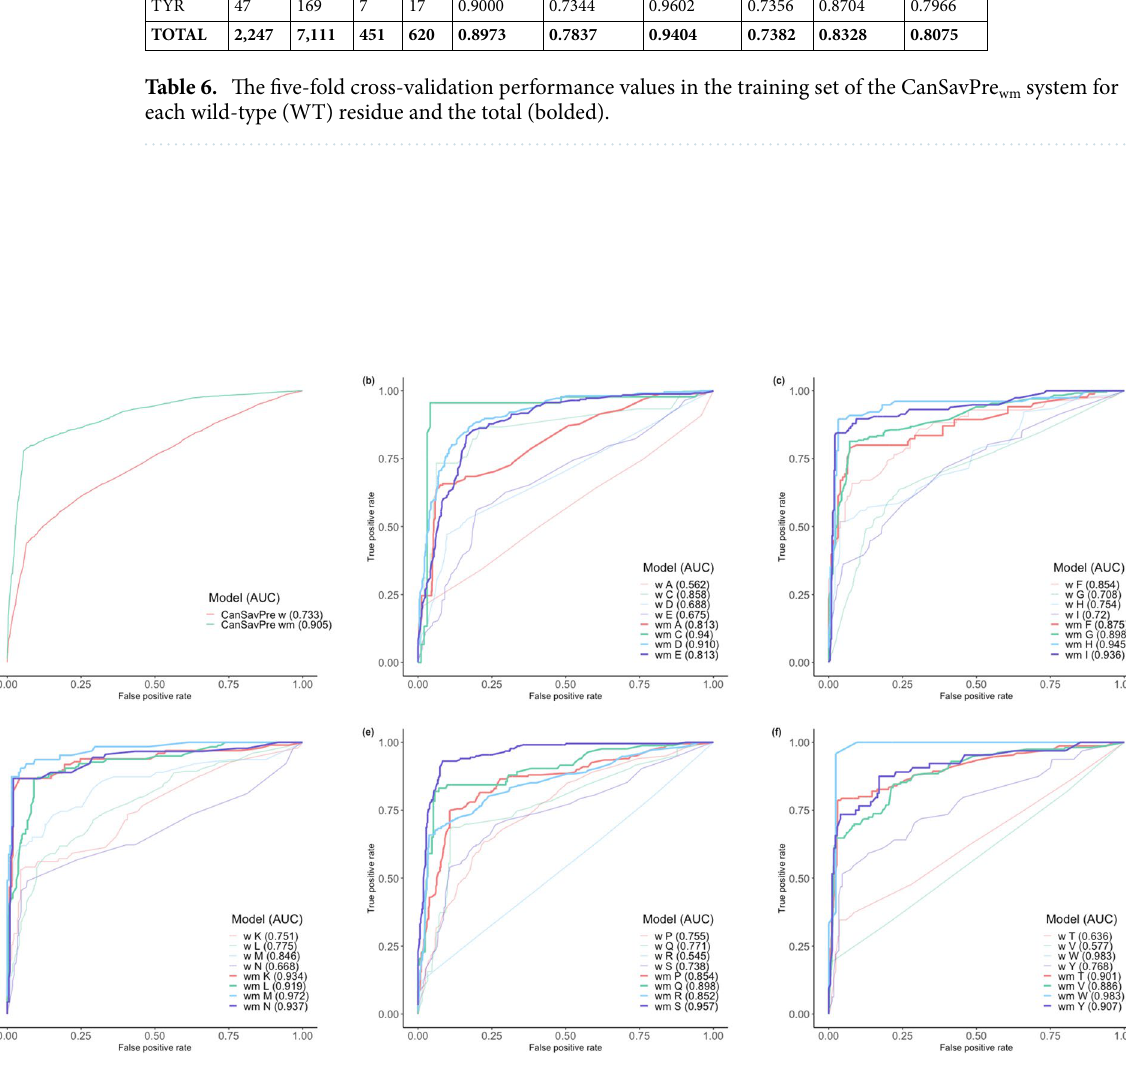
Figure 2. Training set ROC curves in two prediction systems. ( a ) Total groups in the two systems; ( b ) A, C, D, E groups; ( c ) F, G, H, I groups; ( d ) K, L, M, N groups; ( e ) P, Q, R, S groups; ( f ) T, V, W, Y